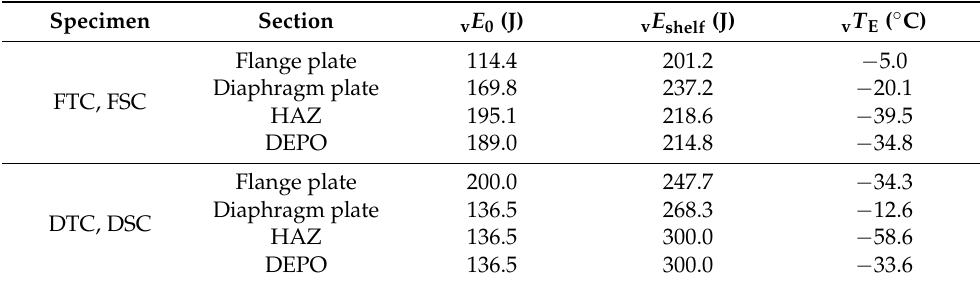
Table 2. Charpy impact test results.